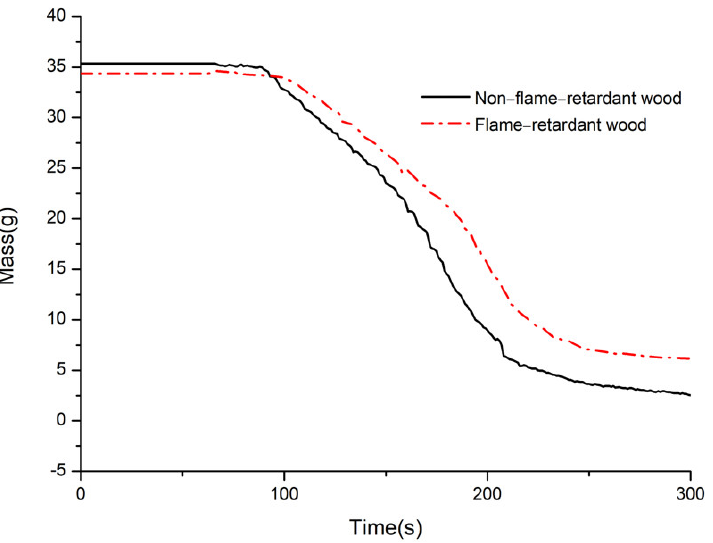
Figure 15. Mass of non-flame retardant bamboo and flame retardant bamboo.